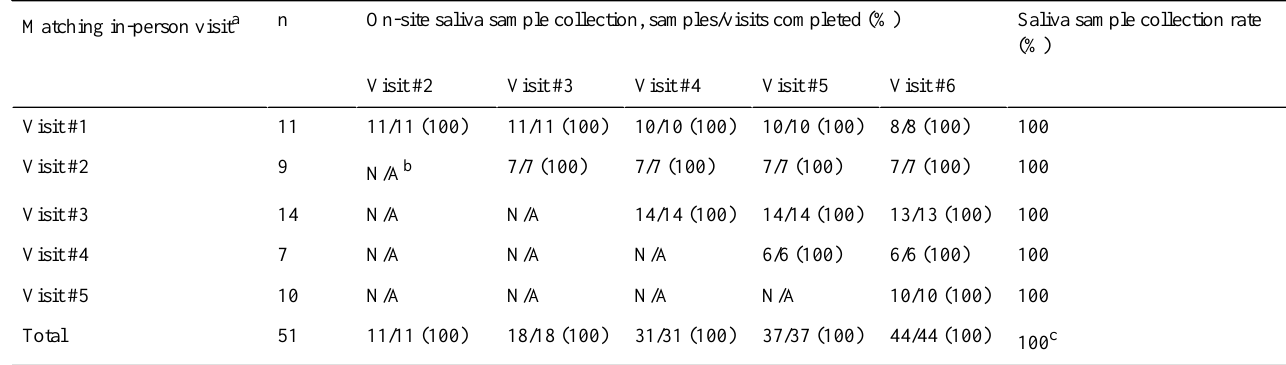
Table 5. Saliva sample collection rates among smoking cessation clinical trial participants by last in-person visit in the pre–COVID-19 cohort (n=51).